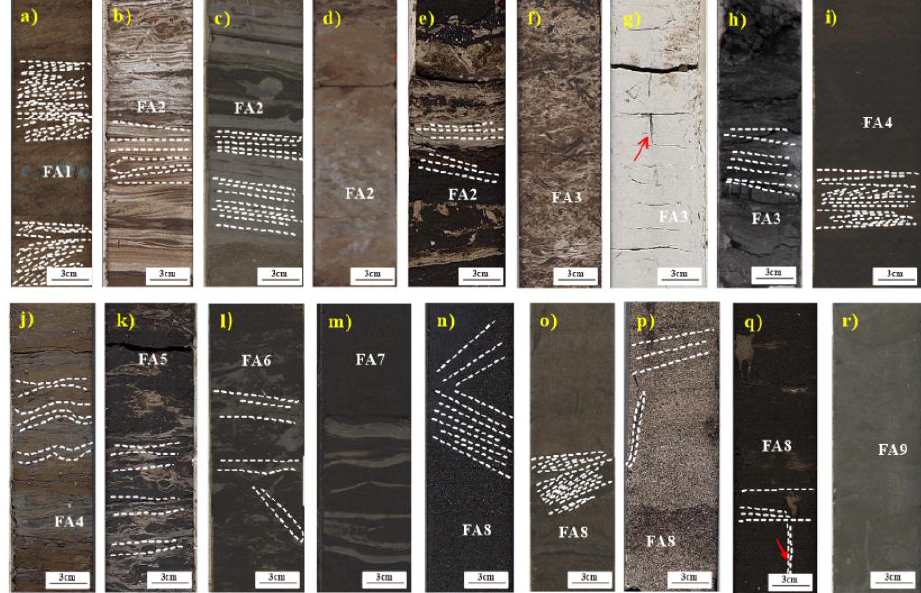
Figure 3. Core data of FA1 – FA9 lithofacies associations. ( a ) Core data of sandy channel filling; ( b – e ) Core data of point bar; ( f – h ) Core data of salt marshes; ( i – j ) Core data of point bar in tidal channels; ( k ) Core data of mudflat; ( l ) Core data of mixed flat; ( m ) Core data of sand flat; ( n – q ) Core data of tidal bar; ( r ) Core data of offshore.